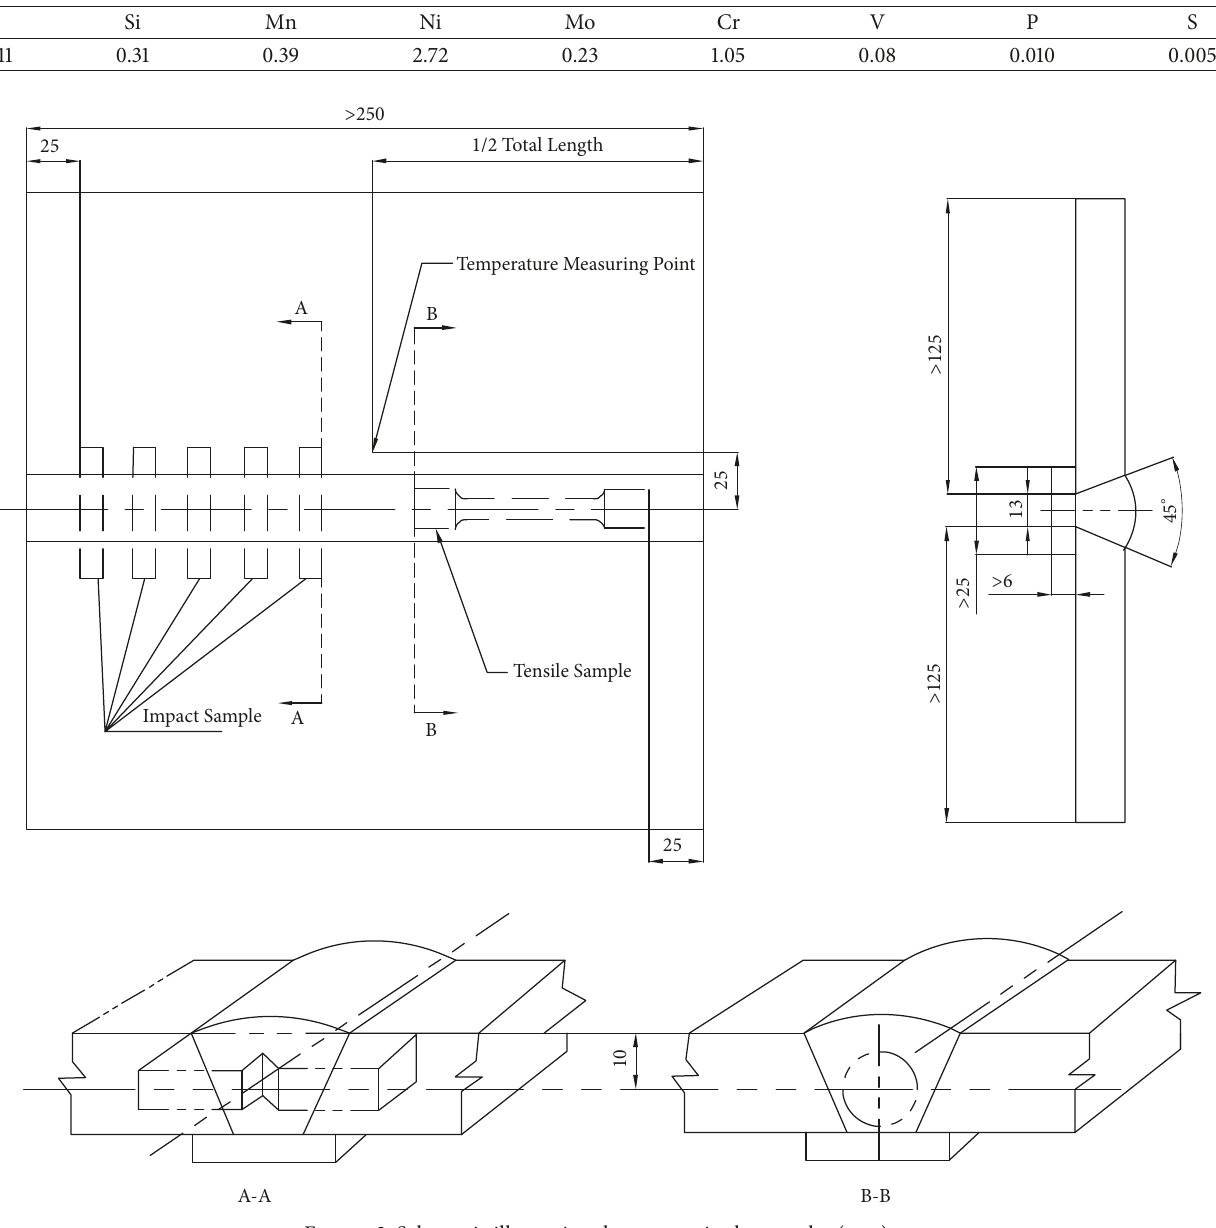
Figure 2: Schematic illustrating the grooves in the samples (mm).